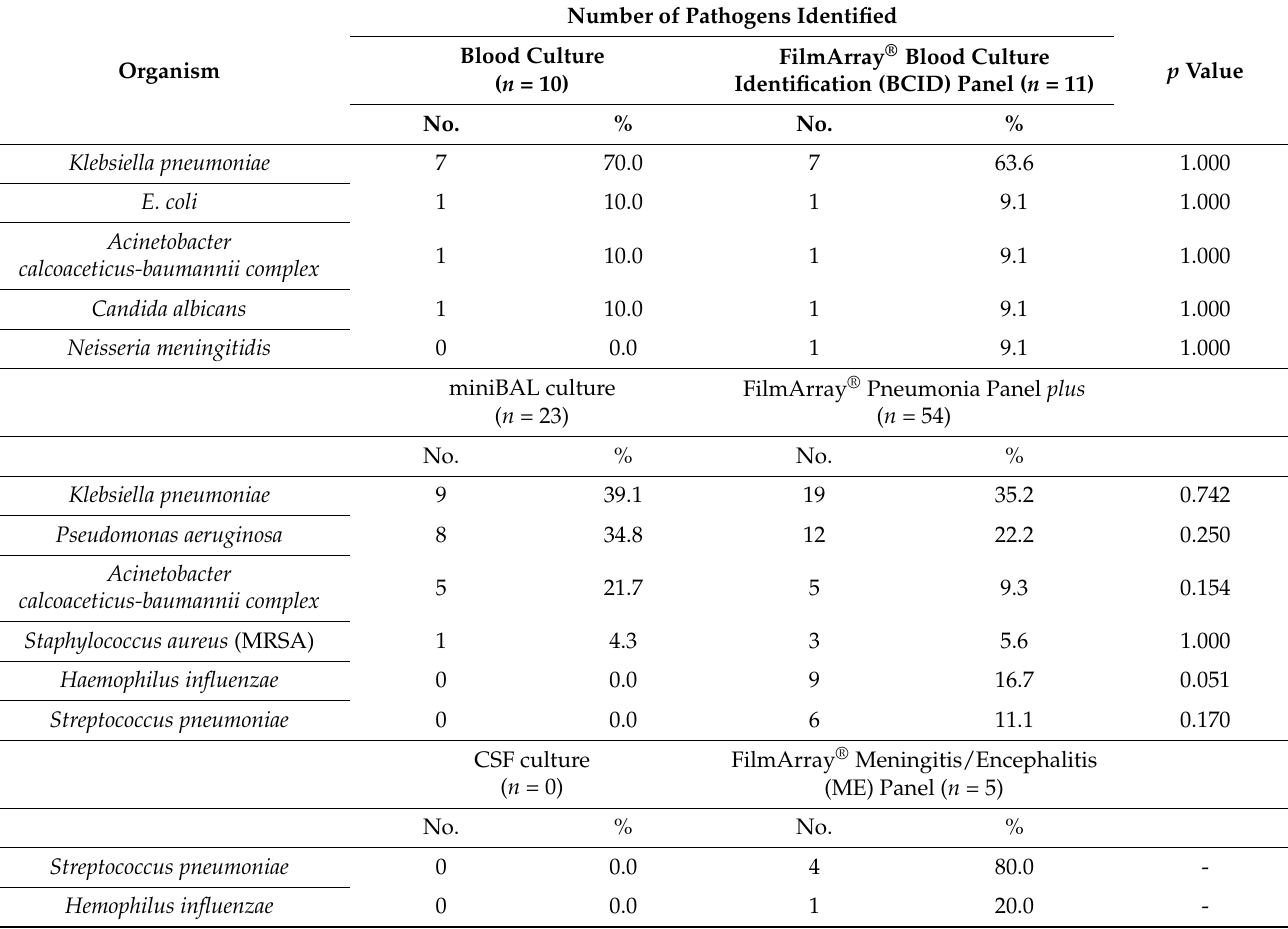
Table 3. Comparison between the results of the BioFire FimArray and SOCMT for the positive